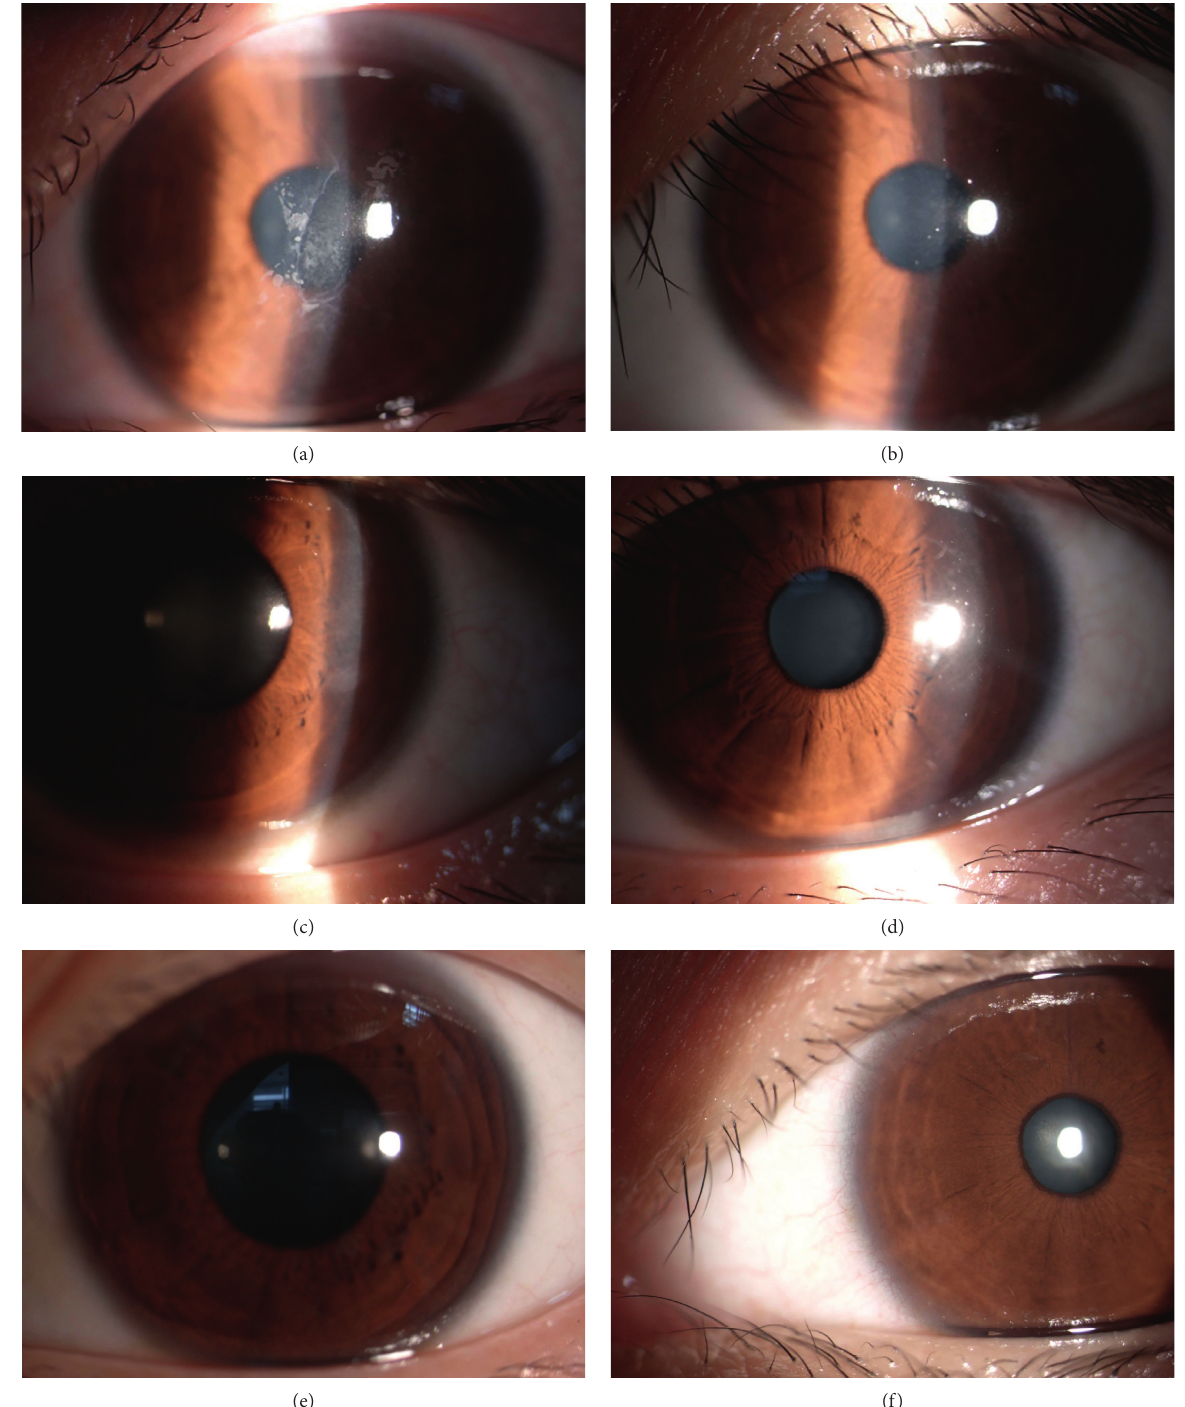
Figure 1: Photographs of the anterior segment of the third patient. (a) shows pre-TPRK, while (b)–(f) show post-TPRK at some follow-up